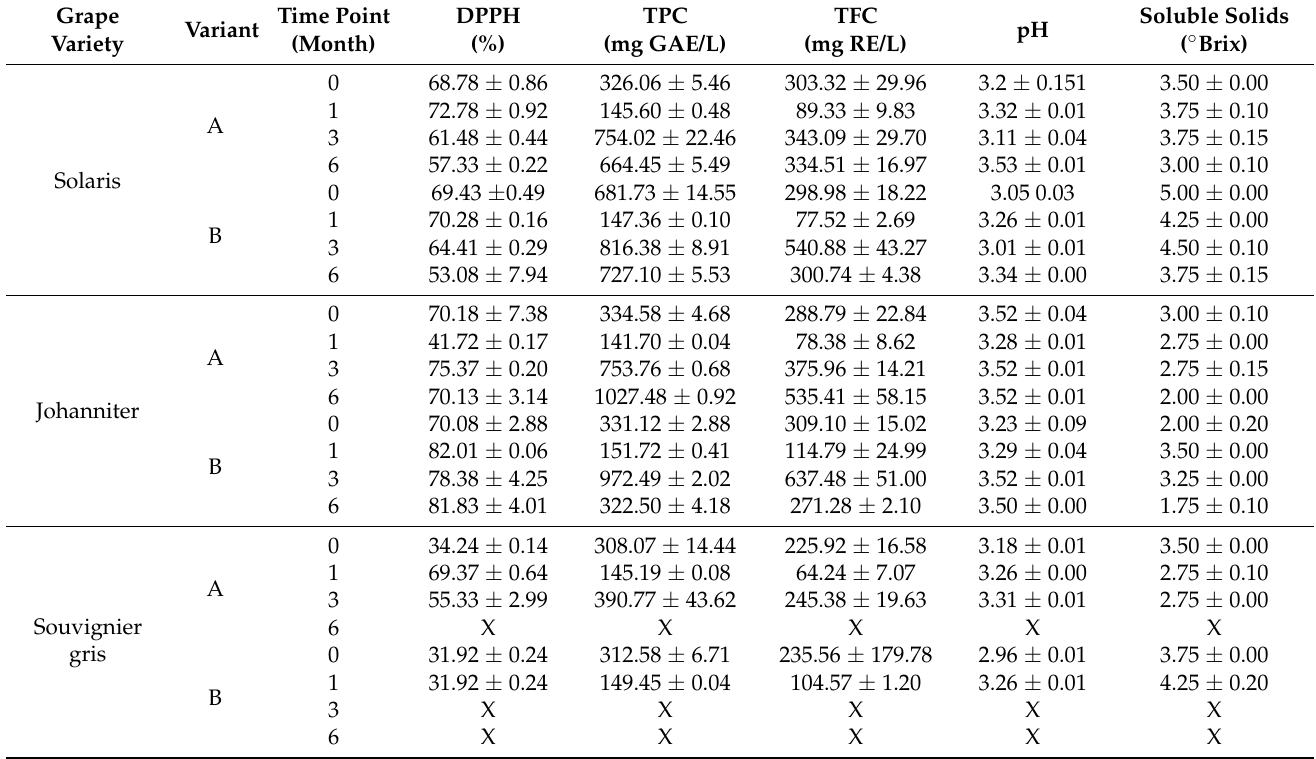
Table 3. DPPH (Antioxidant potential), TPC (Total Phenolic Content), TFC (Total Flavonoid Content), pH and soluble solids content in vinegar samples during storage under refrigerated conditions (4 ◦ C). The results are presented as mean ± standard deviation of 9 replications.